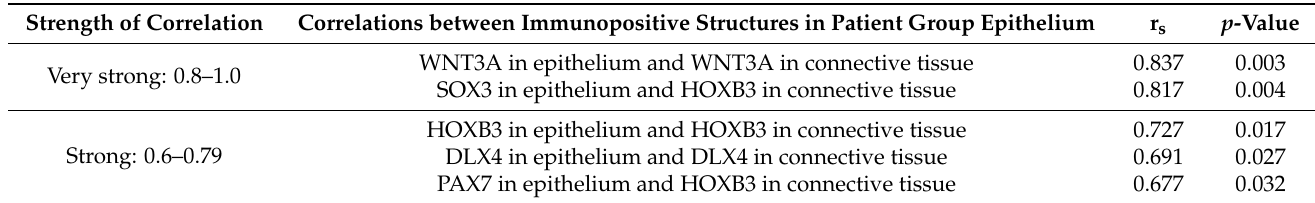
Table 5. Spearman’s rank correlation coefficient correlations between different tissue factors in the patient group epithelium and connective tissue (r s —Spearman’s rho